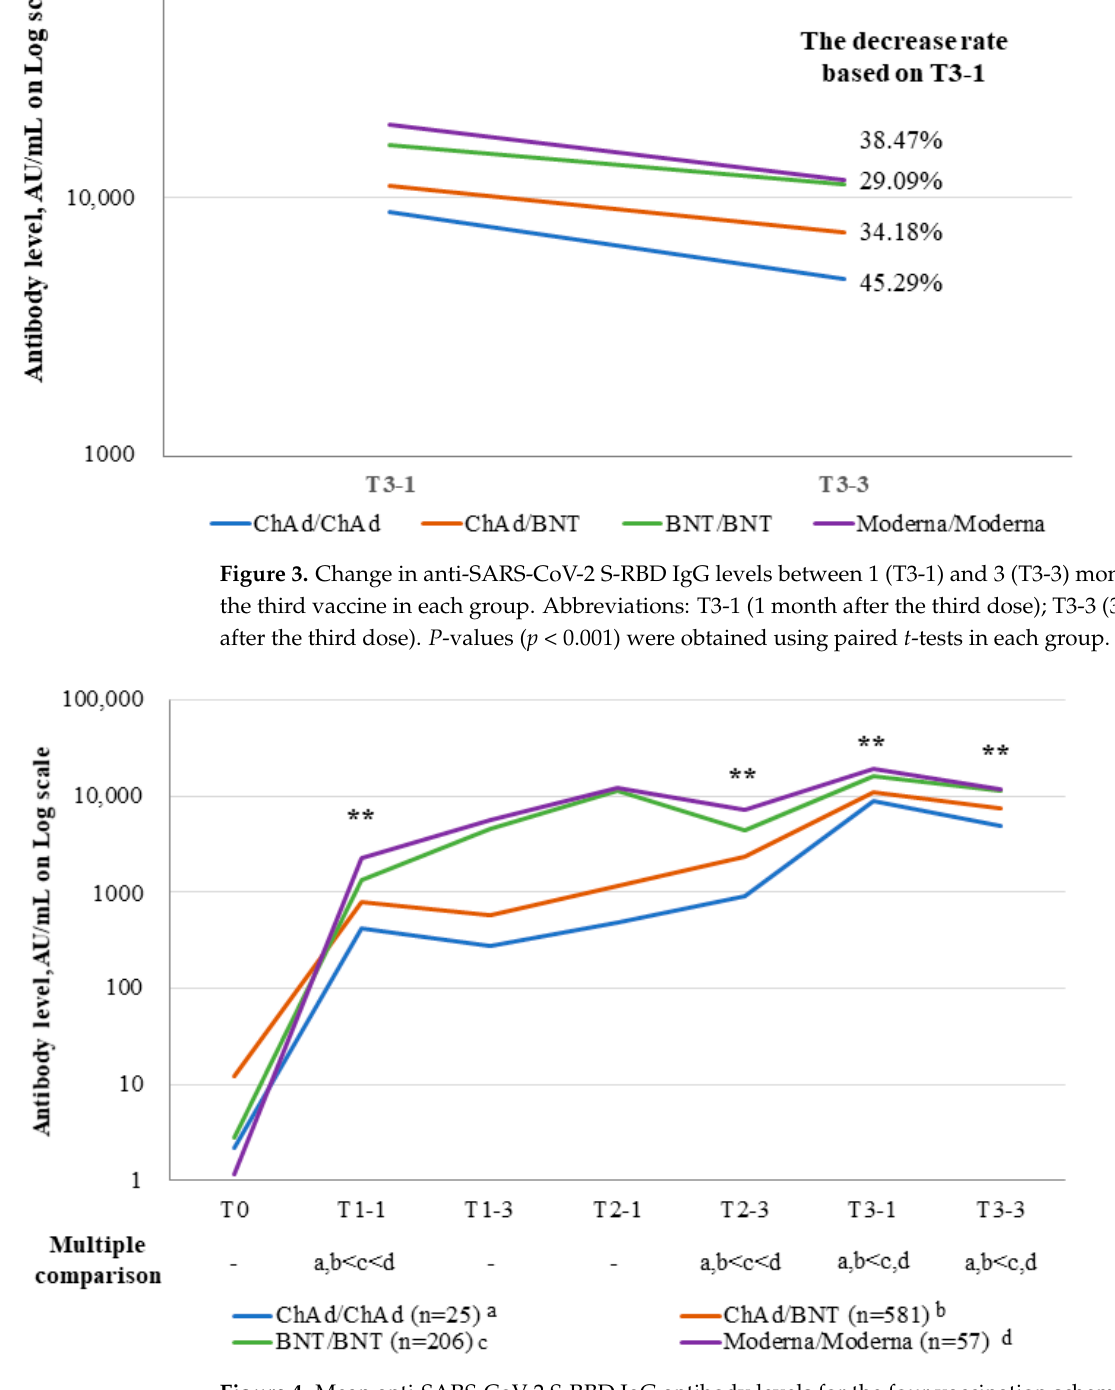
Figure 4. Mean anti-SARS-CoV-2 S-RBD IgG antibody levels for the four vaccination schemes before and after the vaccinations. T0 (day of first dose); T1-1 (1 month after the first dose); T1-3 (3 months after first dose); T2-1 (1 month after the second dose); T2-3 (3 months after the second dose); T3-1 (1 month after the third dose); T3-3 (3 months after the third dose). The mean difference among four vaccination schemes was tested using ANOVA at T1-1, T2-3, T3-1, and T3-3, respectively. ** p -values ( p < 0.001) were calculated using an ANOVA test. 3.3. Factors Associated with Anti-SARS-CoV-2 S-RBD IgG Levels at T3-1 Female sex was associated with anti-SARS-CoV-2 S-RBD IgG levels in the univariable analyses ( p = 0.016), but this association disappeared in the multivariable linear regression analysis ( p = 0.098). Multivariable linear regression analysis indicated that anti-SARS- CoV-2 S-RBD IgG levels at T3-1 were significantly associated with having received mRNA vaccines as the two primary doses ( p < 0.001) (Table 2). Table 2. Factors associated with anti-SARS-CoV-2 S-RBD IgG levels 1 month after the third dose. 1 Month after the Third Vaccination Unadjusted Adjusted Coef.